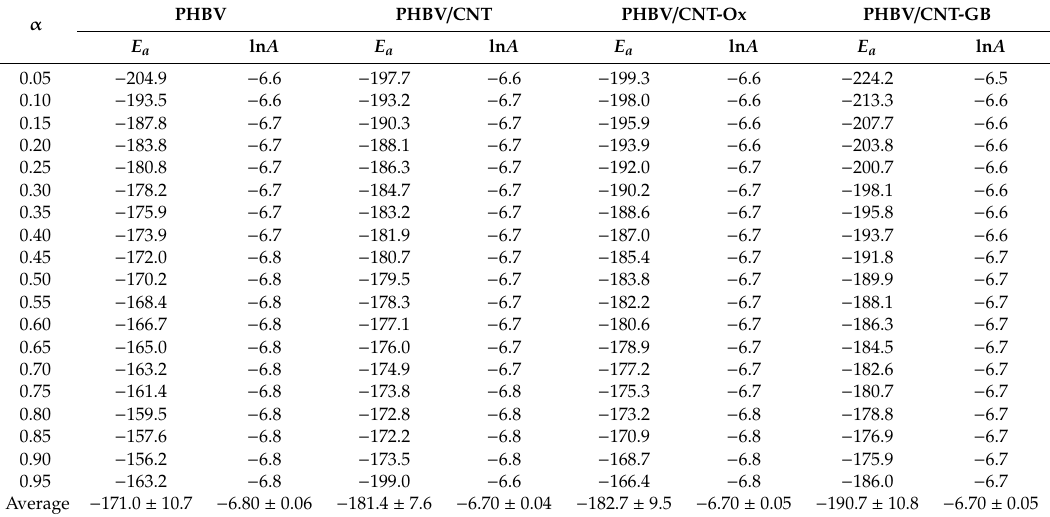
Table 3. Values of E a (kJ / mol) and ln A (min -1 ) for each PHBV conversion fraction ( α ).